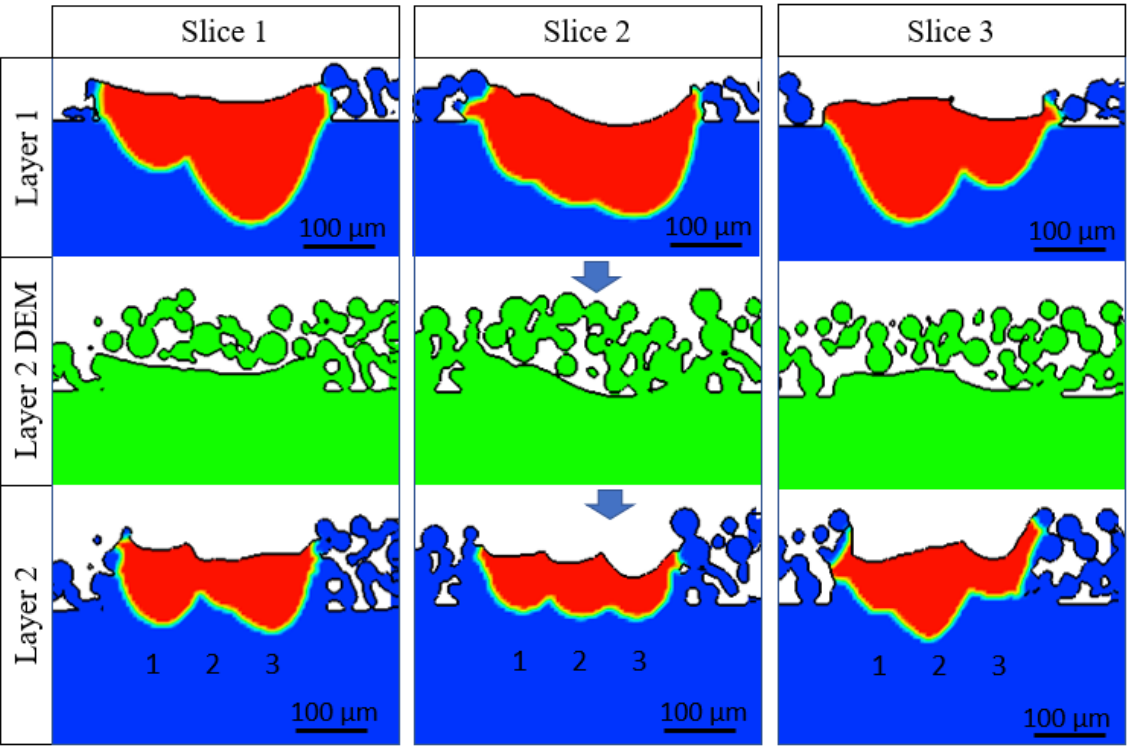
Figure 17. Second layer melt pool boundary obtained with 195 W laser power, 750 mm/s scan speed, 80 µm hatch spacing and 0.5 mm scan length. 80 µ m hatch spacing and 0.5 mm scan